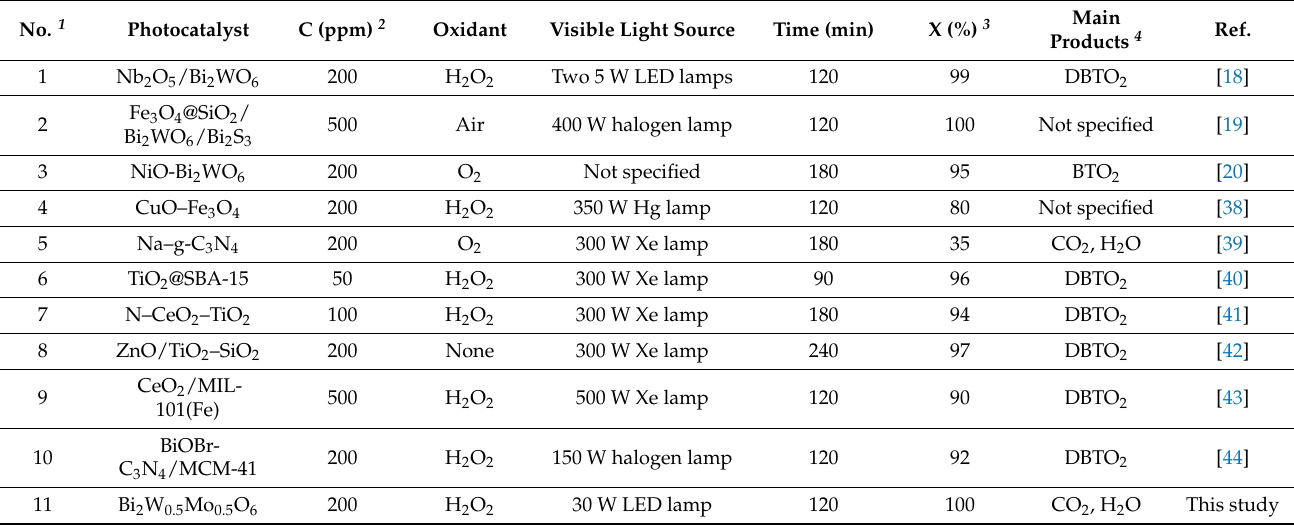
Table 5. Activity of different materials in PODS under visible light